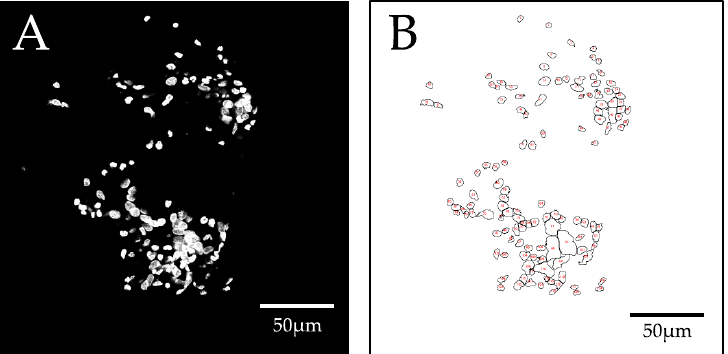
Figure 4. Representation of the segmentation result of the conventional segmentation approach using Fiji. ( A ) original image of a hollow fiber predilection site ( B ) segmented nuclei are outlined and annotated with a red number.